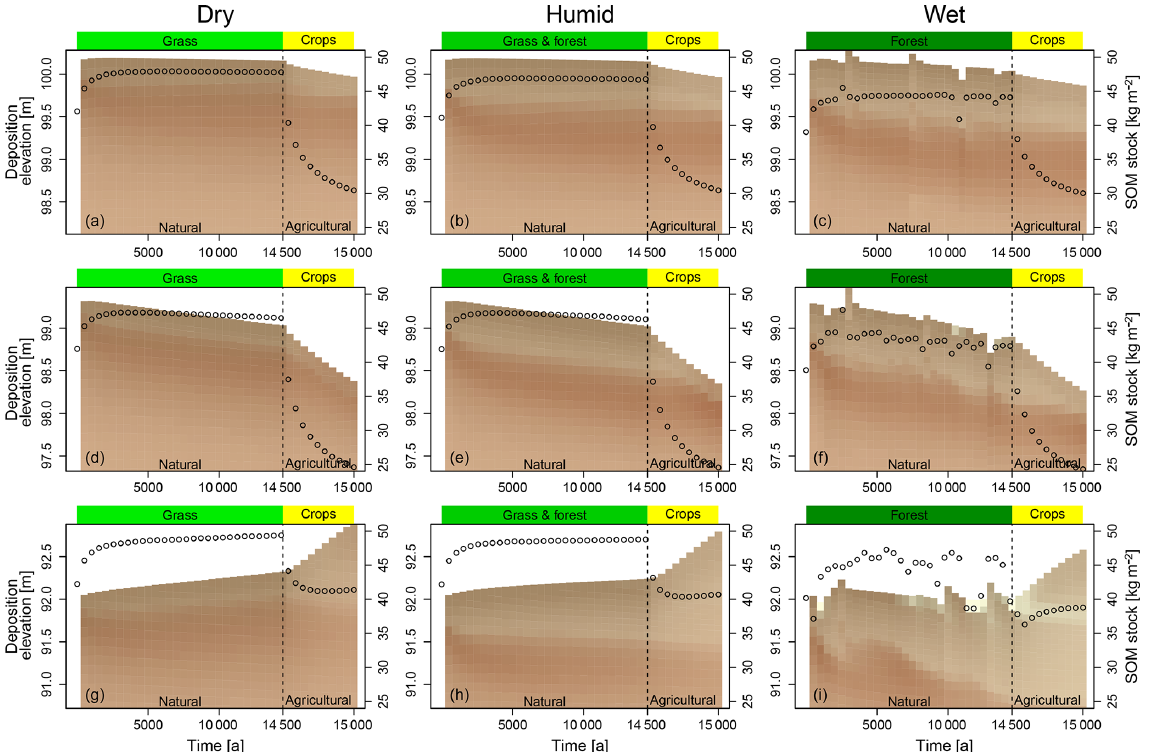
Figure 3. Evolution of soil profiles through time ( x axis) on a stable, eroding and depositing position (rows), for the different rainfall scenarios (columns). The colored bars atop the plots indicate land cover (natural) and land use (agricultural). The points indicate the SOM stocks (right y axis). Note that the natural and agricultural systems have different x axis scales to visualize both systems. In the agricultural system, an observation is shown every 500 years, in the agricultural phase, every 50 years. See Fig. 1 for locations of the soil profiles. See Fig. 2 for the soil color